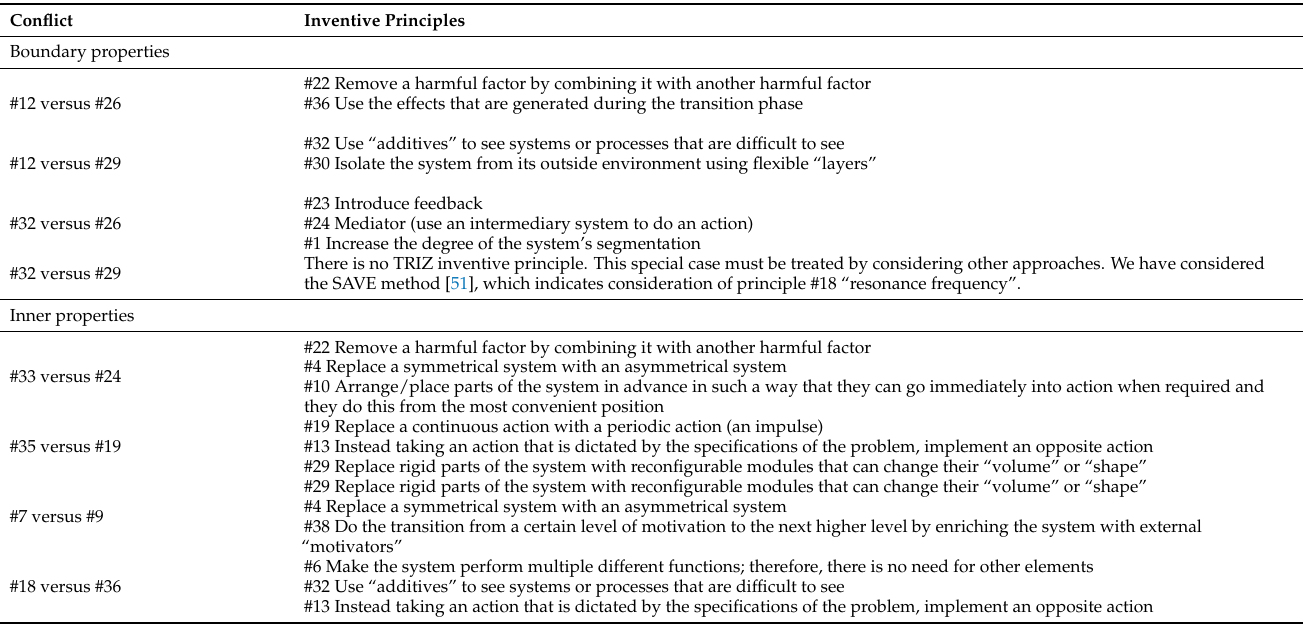
Table 2. Inventive principles for designing the new